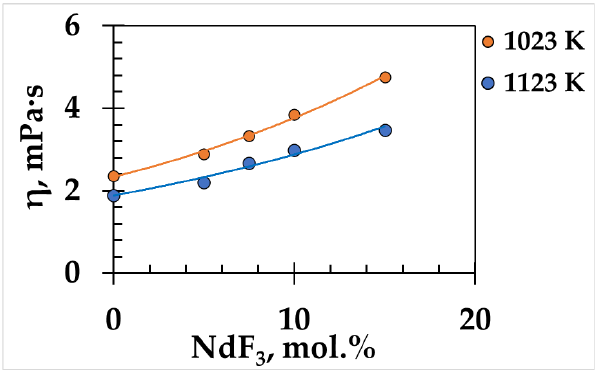
Figure 6. Effect of NdF 3 additions on viscosity of (NaF - KF) eut - NdF 3 .